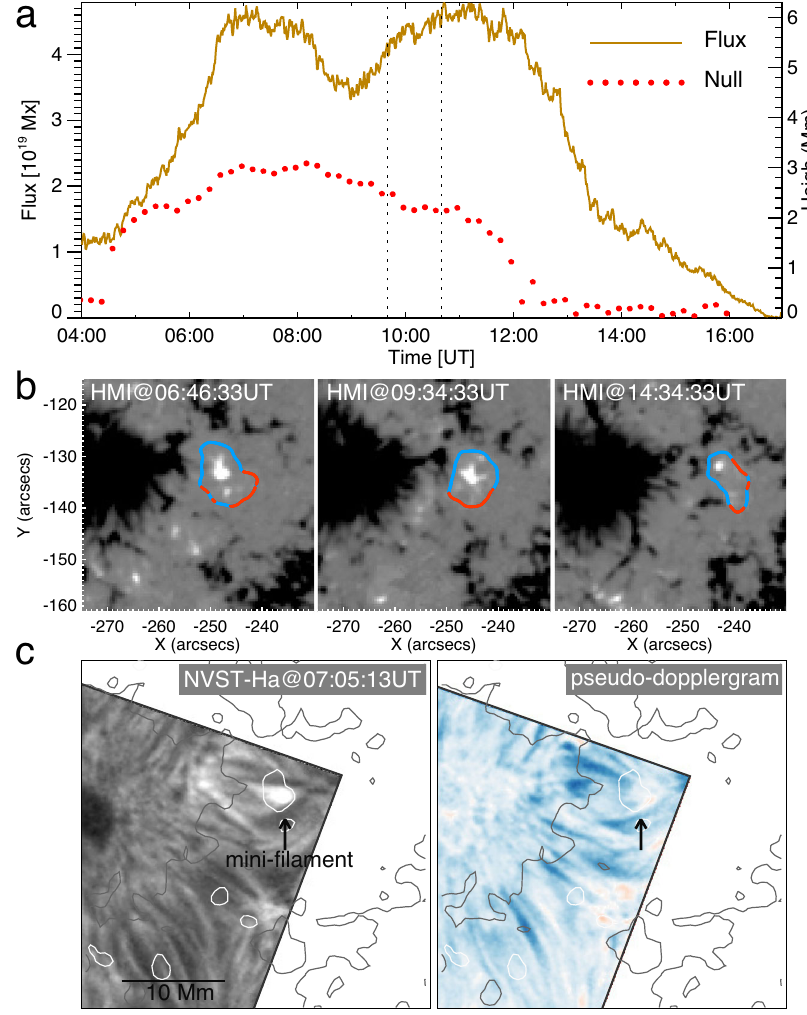
and corresponding pseudo-Doppler map overlaid by the contours (±100G) of the HMI LOS magnetogram with the positive (negative) in white (grey). The arrow pointsoutthemini- fi lament.TheH α pseudo-Dopplerimage,derivedbysubtracting the H α red wing image (at +0.4 Å ) from the H α blue wing image (at − 0.4 Å ), only shows the direction of Doppler